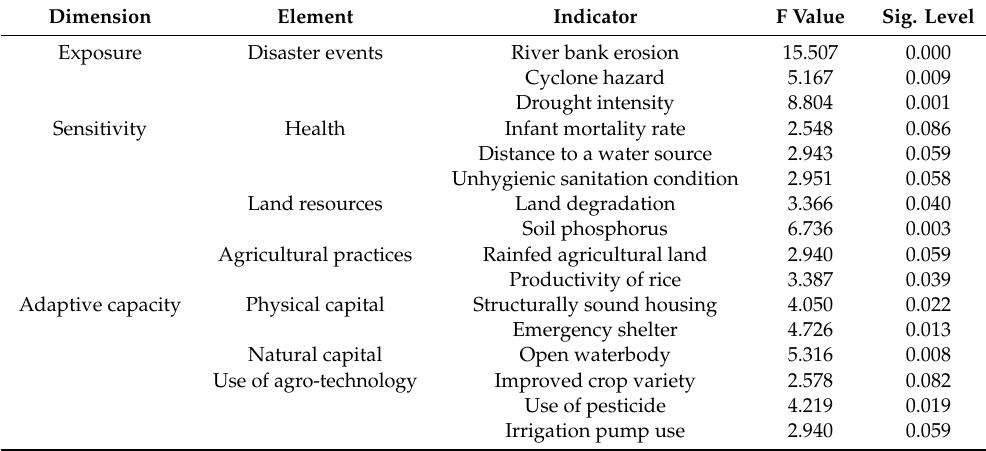
Figure 4. Spatial analysis showing the pattern of vulnerability distribution across the study area: ( A ) Moran scatter plot of the ALVI values; ( B ) LISA cluster map; ( C ) LISA significance map. The red and blue color areas in map ( B ) indicate ‘hot spots’ and ‘cold spots’ of vulnerability distribution, respectively.